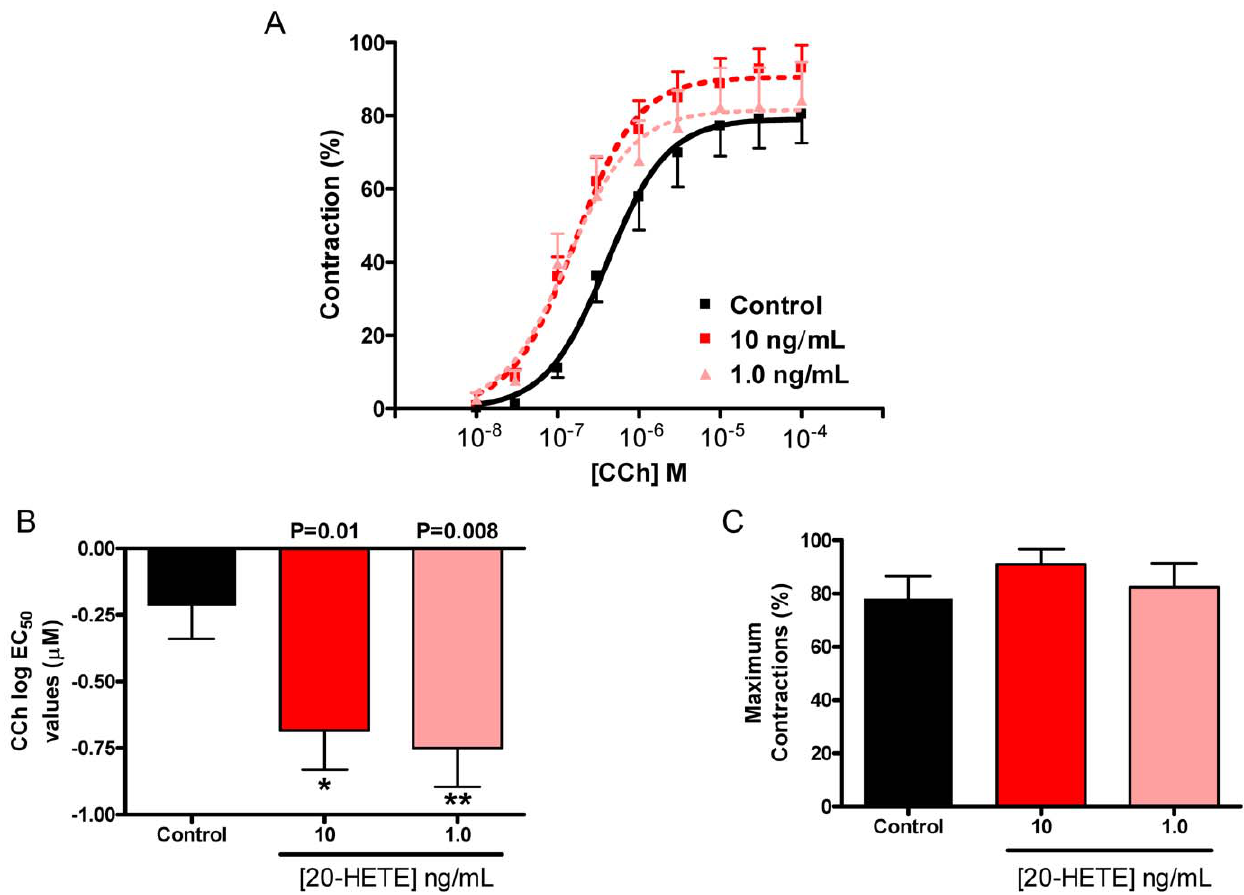
Figure 7. 20-HETE increases murine airway sensitivity to carbachol. Lung slices from naı¨ve mice were incubated over-night with 20-HETE (10 and 1 ng/mL). (A) Airways were contracted to carbachol (CCh) to create concentration-response curves. Incubation with 20-HETE (B) decreased log EC 50 values; but, (C) had no effect on maximum contraction compared to control slices. Data expressed as mean 6 SEM shown; * P # 0.05 and ** P # 0.01 vs control (exact P values shown). At least 8 airways were used in each group, and never more than 12.